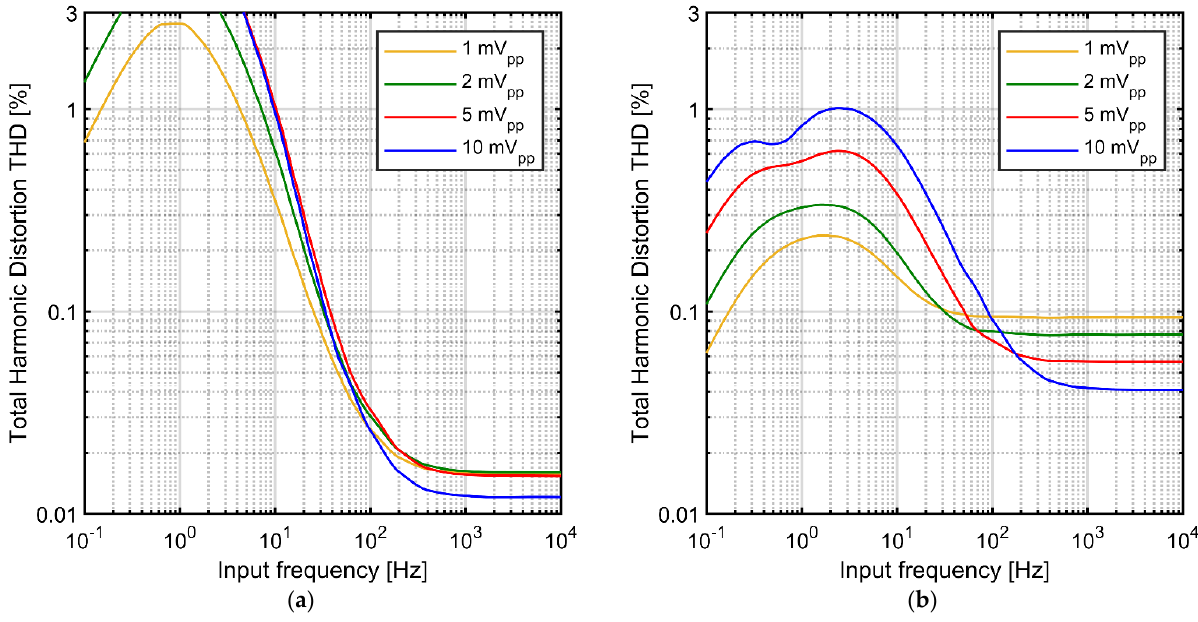
Figure 3. Simulated THD vs. signal frequency for AC-coupled neural amplifier (with 1 Hz cutoff frequency) and for various input signal amplitudes: ( a ) using the variable- V gs pseudoresistor ( b ) using the symmetric fixed- V gs pseudoresistor.